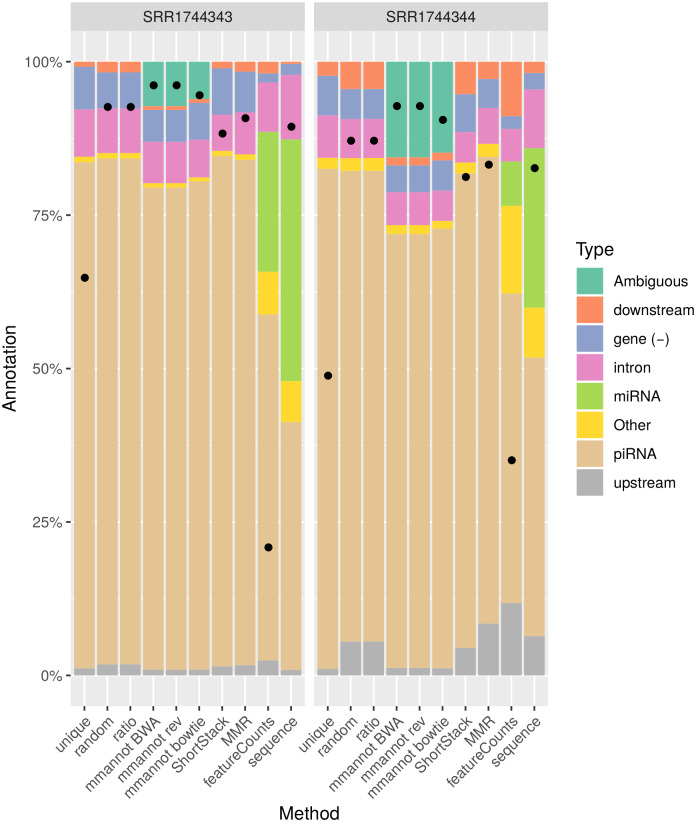
Comparison of the different strategies on the S. scrofa data sets.See Fig 2 for a legend of the plot.